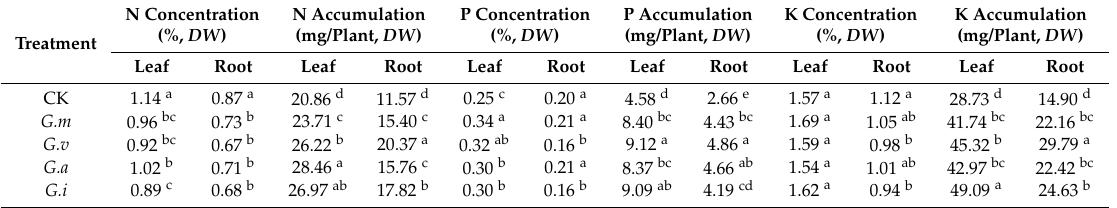
Table 5. Effect of AMFs on N, P and K concentration and accumulation of S. miltiorrhiza seedlings.